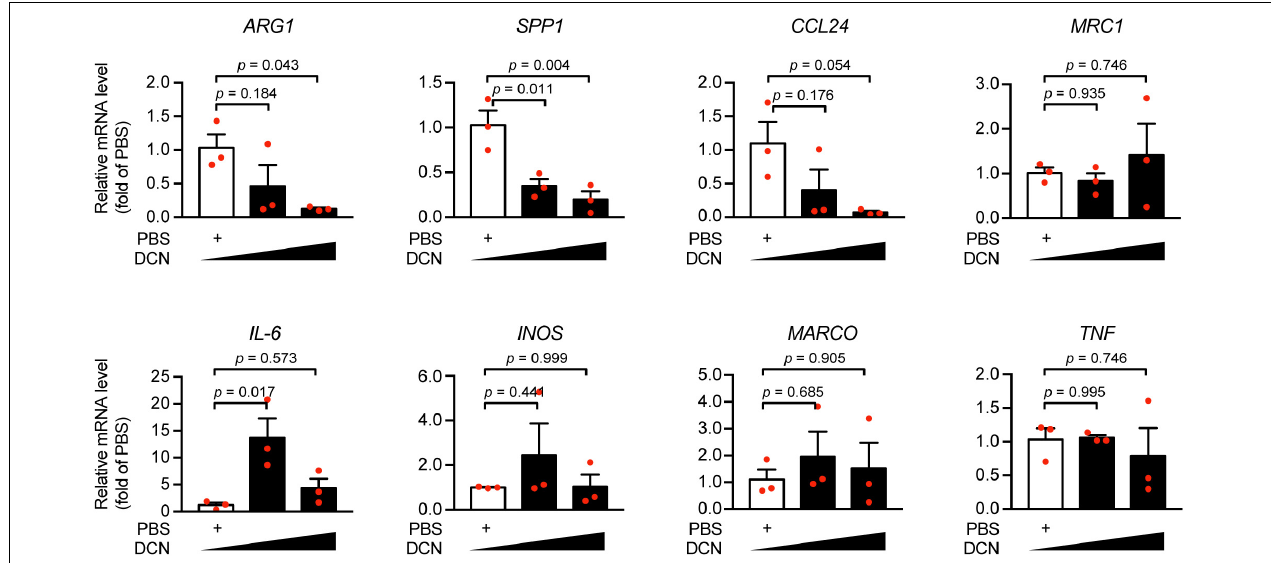
FIGURE 4 | DCN elicited pro-inflammatory responses under ischemic conditions. Human mononuclear cells (MNC) were treated with recombinant human DCN protein (20 ng/mL, or 60 ng/mL) or PBS and the mRNA expression of ARG1, SPP1, CCL24, MRC1, IL-6, INOS, MARCO, TNF was determined by quantitative real-time polymerase chain reaction